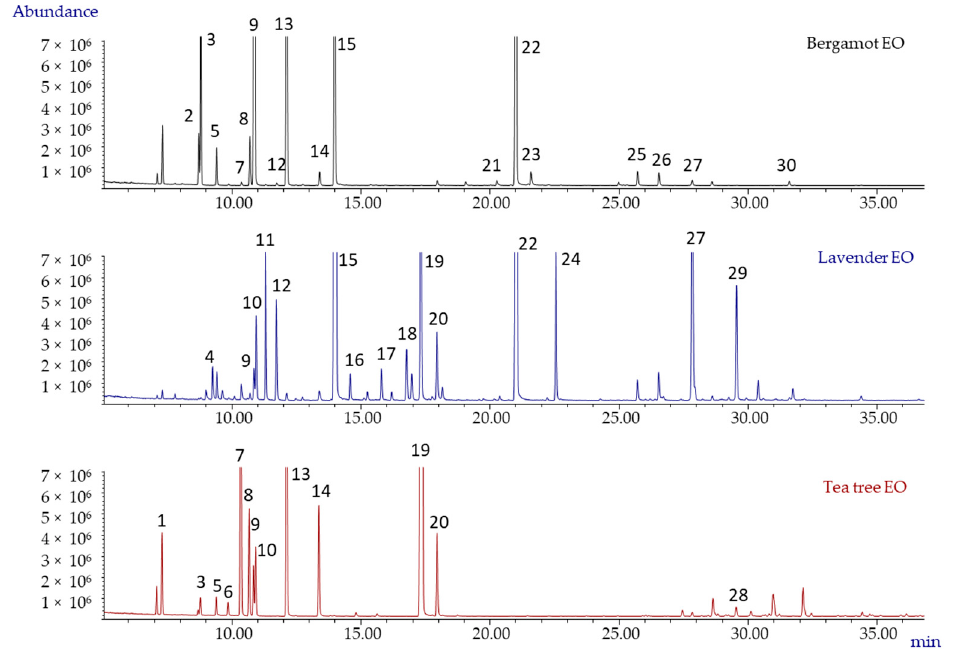
Figure 1. GC-MS patterns of genuine bergamot, lavender and TTO EO. Legend: (1) α -pinene, (2) sabinene, (3) β -pinene, (4) 3-octanone, (5) β -myrcene, (6) α -phellandrene, (7) α -terpinene, (8) p -cymene, (9) limonene, (10) 1,8-cineole, (11) cis - β -ocimene, (12) trans - β -ocimene, (13) γ -terpinene, (14) α -terpinolene, (15) linalool, (16) 1-octen-3-yl acetate, (17) camphor, (18) lavandulol, (19) 4-terpineol, (20) α -terpineol, (21) neral, (22) linalyl acetate, (23) geranial, (24) lavandulyl acetate, (25) neryl acetate, (26) geranyl acetate, (27) trans - β -caryophyllene, (28) aromadendrene, (29) trans - β -farnesene and (30) β -bisabolene. For the analysis conditions, see the main text.